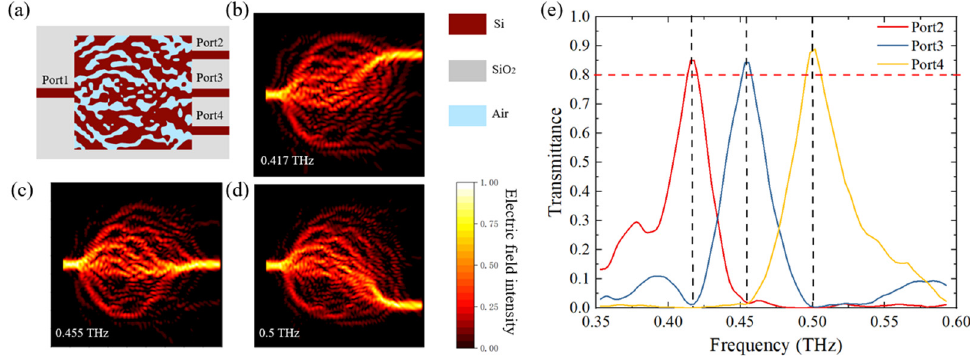
Figure 5. The final optimized structure of the three-port THz demultiplexer ( a ), the distributions of